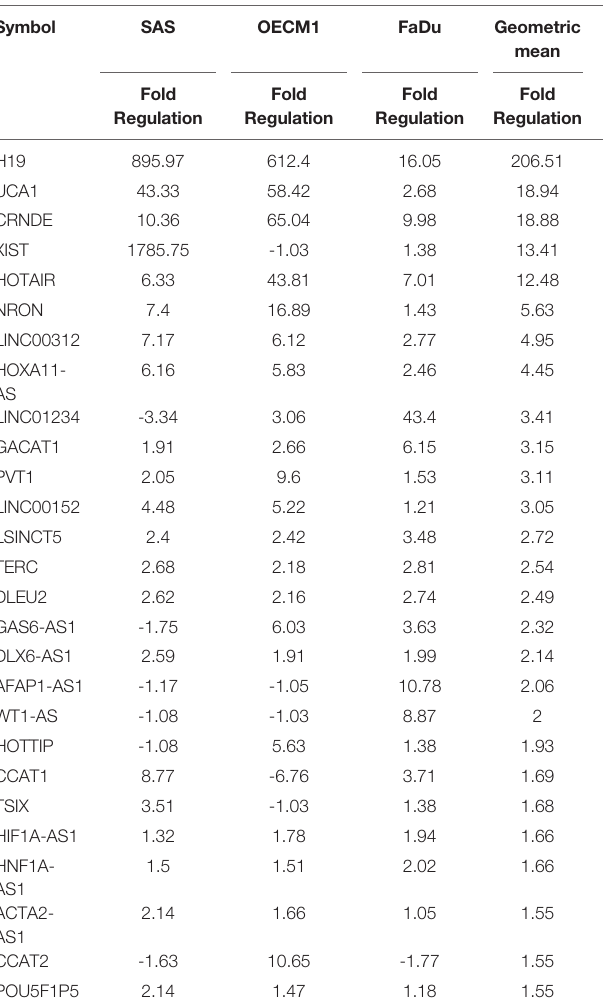
TABLE 2 | List of downregulated genes across the HNC cell line group compared with the normal keratinocyte cell line group. Down-Regulation (n = 28, comparing to control group) Symbol SAS